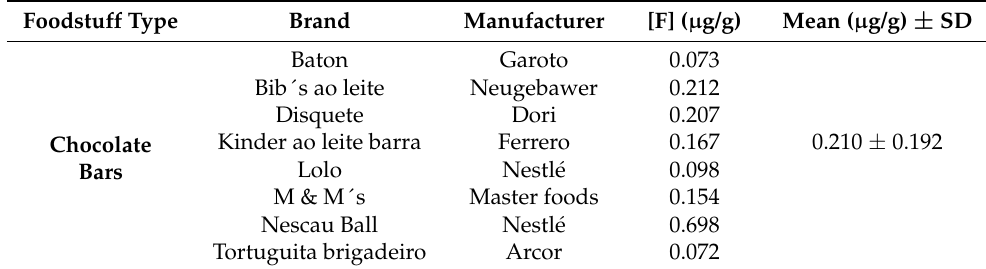
Table 4. Mean of fluoride content of the different types of chocolate bars that were